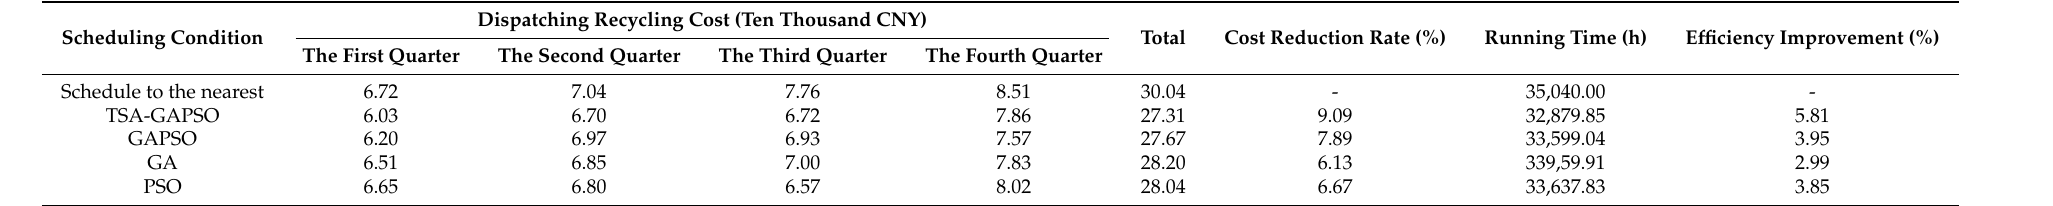
Table 2. The algorithm statistics index data of mine water dispatching